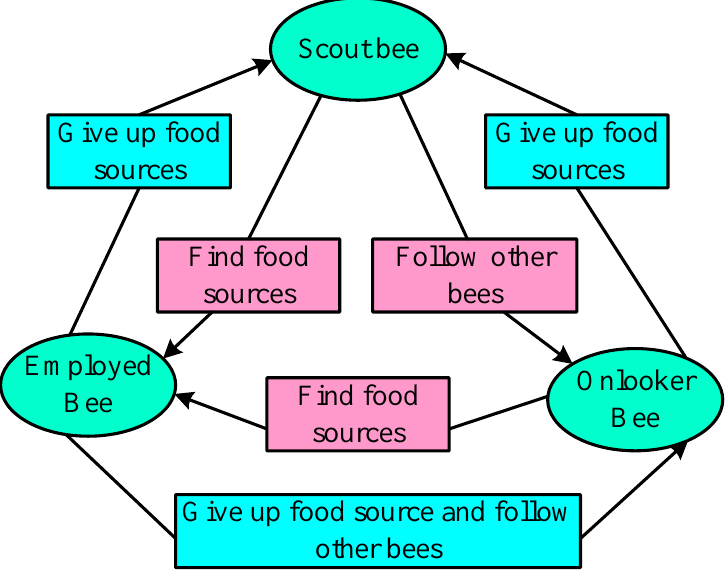
Figure 7. Conversion behavior diagram of the three kinds of bees. Table 2. Correspondence between honey collection behavior and optimization problem. Nectar-Collecting Behavior of